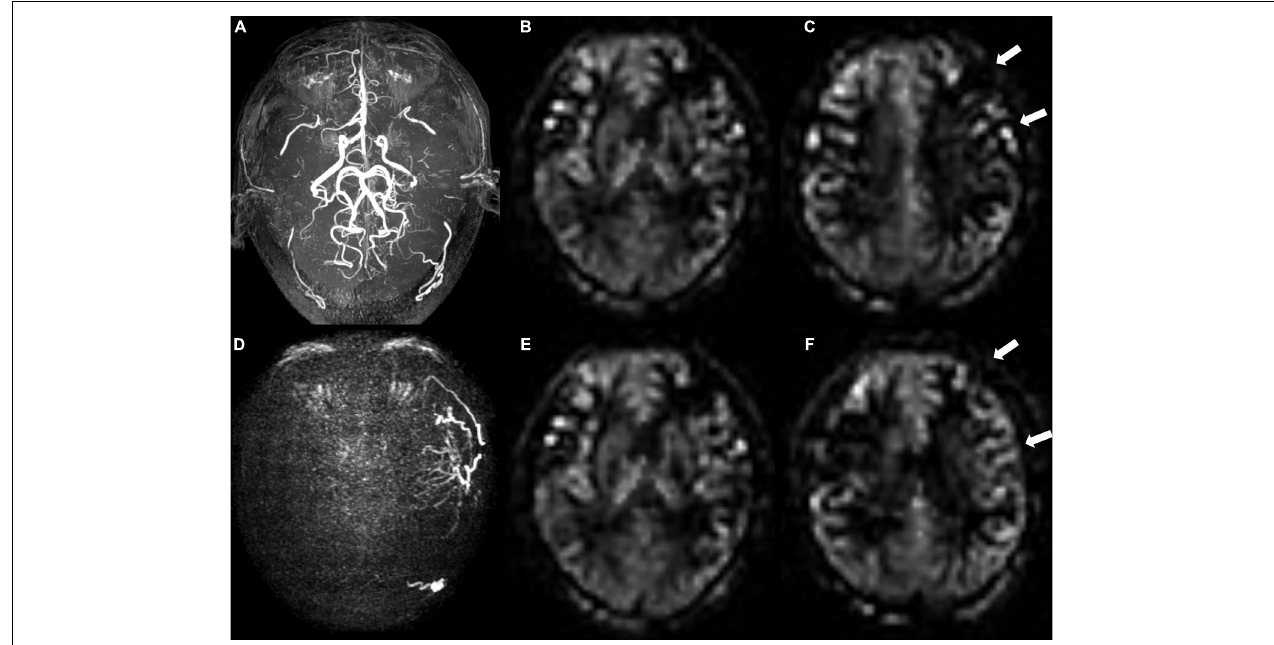
FIGURE 3 | A 48-year-old male patient with moyamoya angiopathy. (A) Presurgical MR angiography image. (B,C) Two-slice ASL images of ASPECT regions, and preoperative collateral score was 10 in (B) and 9 in (C) . (D) Postoperative super-selective 4D MRA images of external carotid artery. Postsurgical collaterals were defined as poor (1 score according to Matsushima standard). (E,F) Same postoperative two-slice ASL images as (B,C) . Postoperative collateral scores increased (white arrows) to 10 in (E) and 11 in (F) .